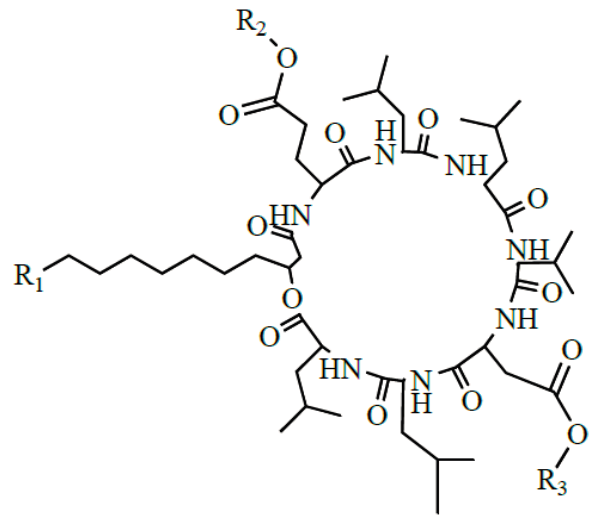
Figure 5. The structures of B1, B2, B3 and B4. B1: R 1 = C 5 H 11 , R 2 = C 4 H 9 , R 3 = H or R 1 = C 5 H 11 , R 2 = H, R 3 = C 6 H 13 ; B2: R 1 = C 6 H 13 , R 2 = C 6 H 13 , R 3 = H or R 1 = C 6 H 13 , R 2 = H, R 3 = C 6 H 13 ; and B3: R 1 = C 5 H 11 , R 2 = C 6 H 13 , R 3 = C 6 H 13 ; B4: R 1 = C 6 H 13 , R 2 = C 6 H 13 , R 3 = C 6 H 13